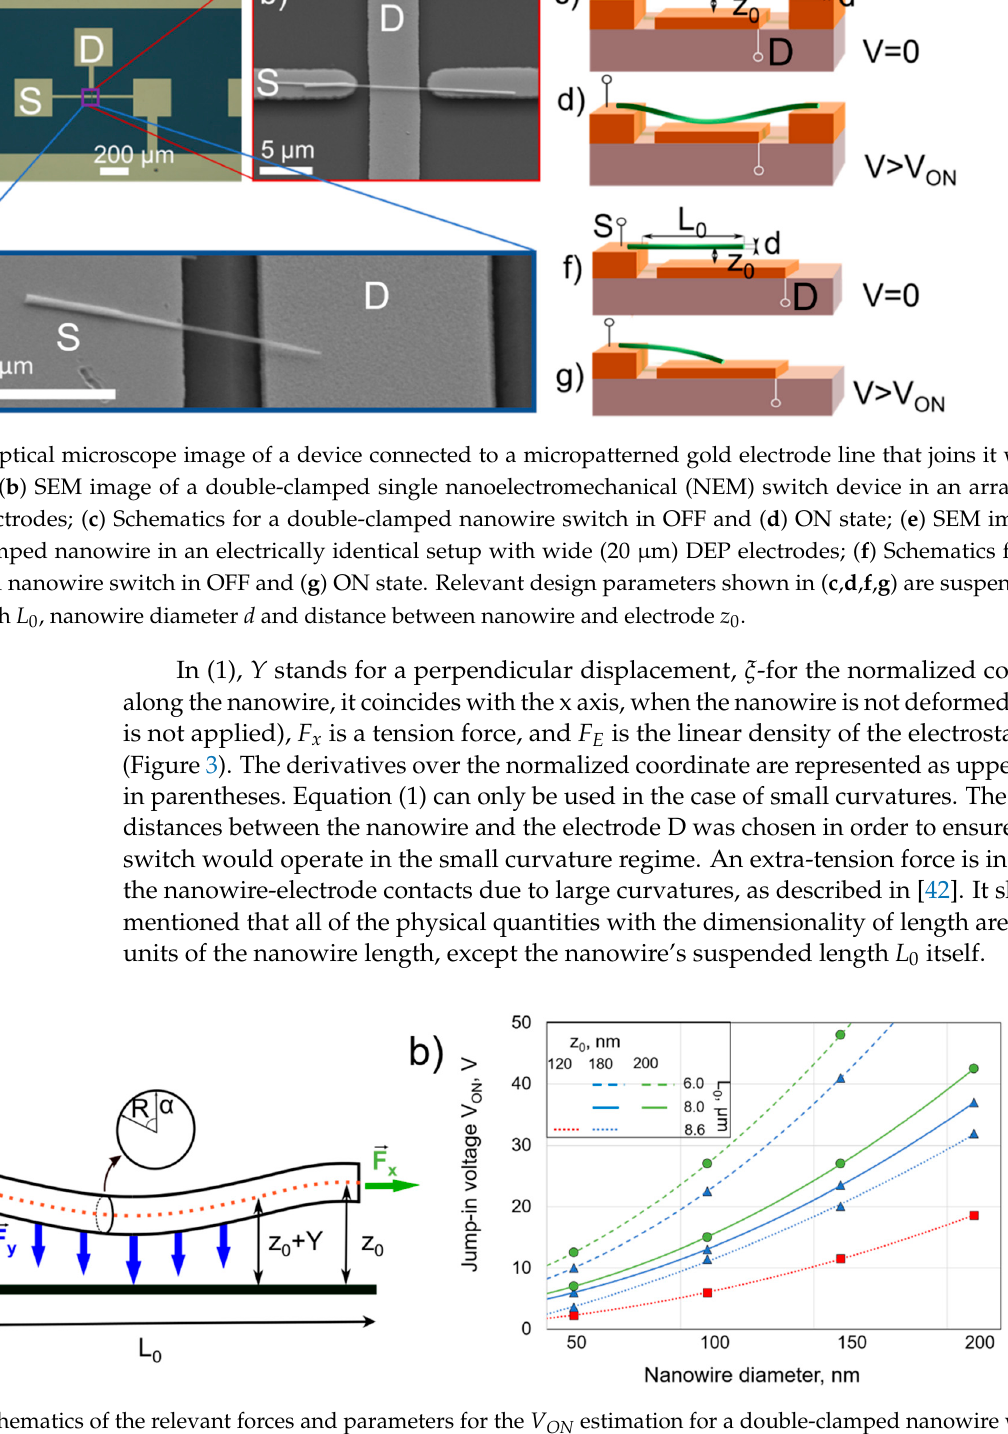
Figure 3. ( a ) Schematics of the relevant forces and parameters for the V ON estimation for a double-clamped nanowire with suspended length L 0 , diameter d (radius R ) and initial distance to the electrode z 0 . ( b ) Calculations of V ON as a function of nanowire diameter for different distances between the nanowire and the electrode z and suspended lengths L 0 for a Young’s modulus of 155 GPa, assuming a rigid clamping at the nanowire ends. The lines are drawn as guide to the eye. The suspended lengths are marked by line type (dashed line 6 μ m, solid line 8 μ m, dotted line 8.6 μ m), distances are marked by colored shapes (red square corresponds to 120 nm, blue triangle to 180 nm, and green circle to 200 nm).